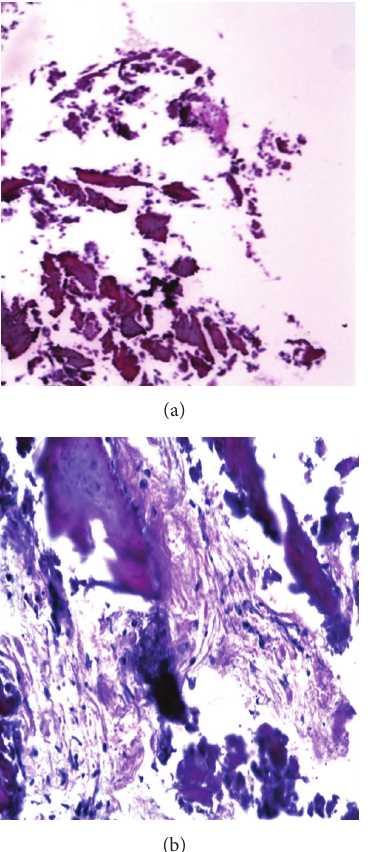
Figure 9: (a) Microscopic findings of implanted bone showing frag- ments of bone embedded in fibrous tissue (hematoxylin and eosin 106x). (b) The same fragments at higher magnification showing fibroblasts, calcifications, fragments of bone tissue, and traces of grafted material (hematoxylin and eosin